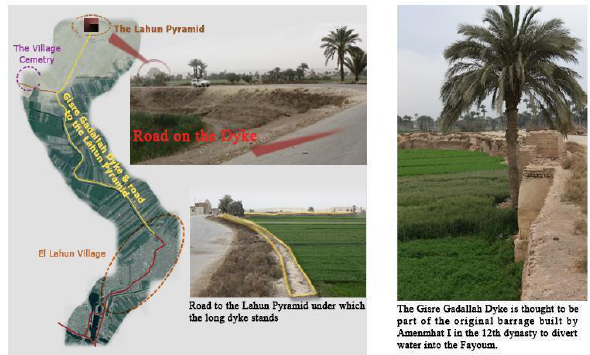
Figure 3. Google map image, 2009, View of Gisr Gadallah barrage, from the village and to the